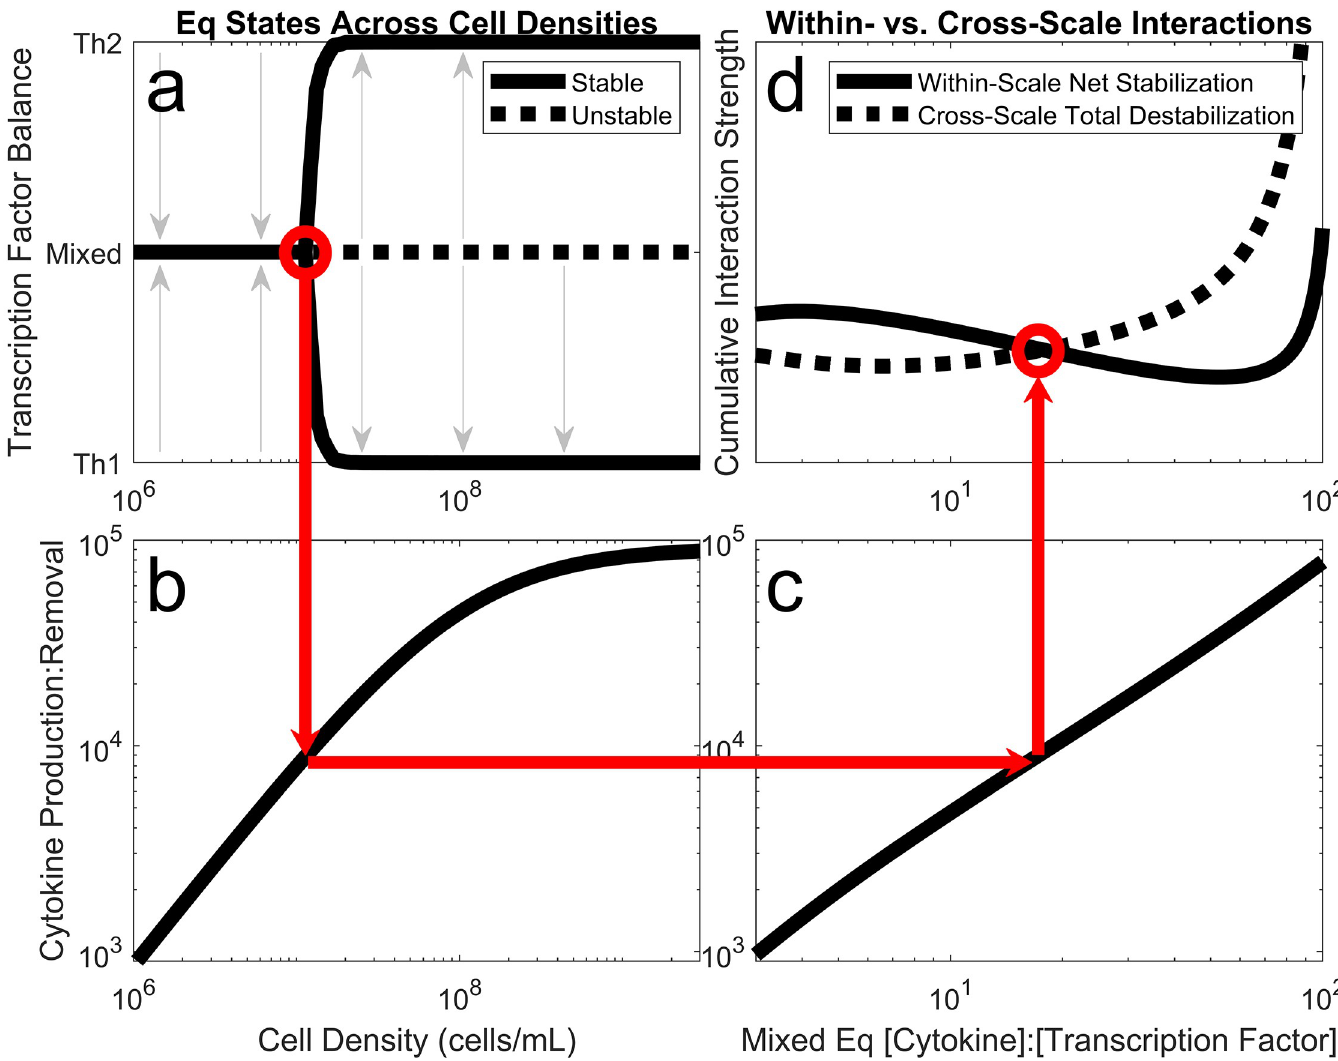
Fig 4. Th group polarization emerges as cell density increases, due to the changing relative strengths of within-scale vs. cross-scale molecular interactions. (a) The stable effector balance among a group of Th cells transitions from mixed to polarized as the quorum cell density is surpassed. (b) The quorum cell density corresponds to a particular ratio of cytokine production: removal. (c) This cytokine production: removal ratio controls the ratio of cytokine: transcription factor expression at the mixed effector type equilibrium (y-axis is independent variable and x-axis is dependent variable). (d) The ratio of cytokine: transcription factor expression controls whether the net stabilizing effect of within-scale molecular interactions or the total destabilizing effect of cross-scale molecular interactions is stronger, and therefore whether the mixed equilibrium is stable or